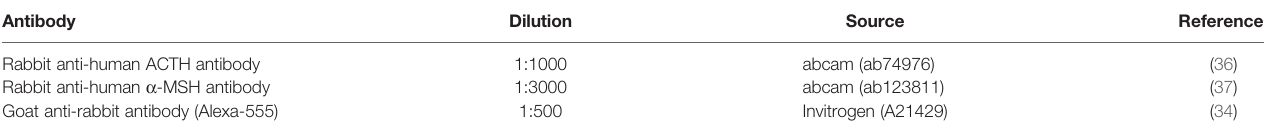
TABLE 3 | Primary and secondary antibodies used for immuno fl uorescence (IF) to distinguish Acth and a -Msh cells within pomca -expressing cells in the medaka pituitary. Antibody